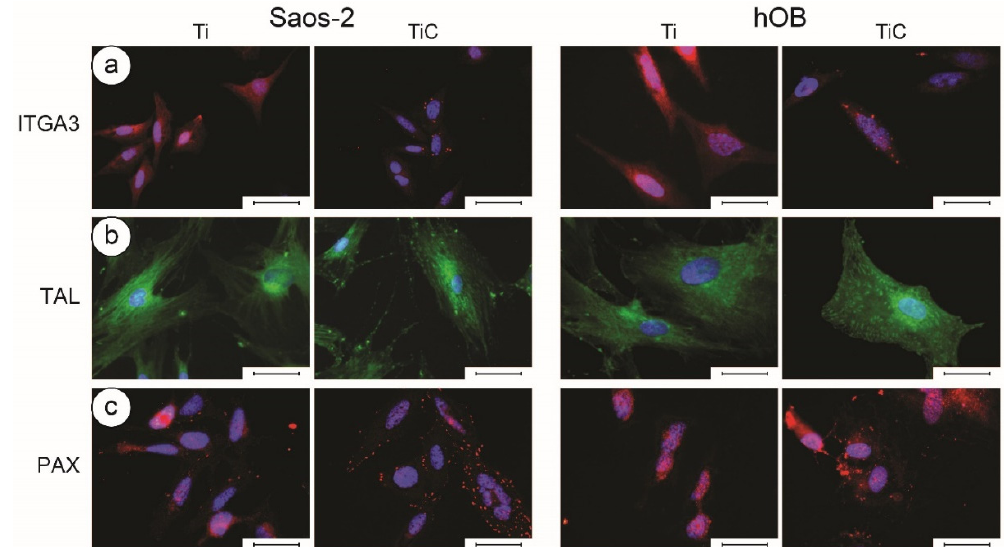
Figure 6. Immunofluorescence images of integrin α 3 β 1, talin and paxillin in Saos-2 cells and in human primary osteoblasts (hOB). Panel ( a ): The Saos-2 (left panels) and the hOB cells (right panels) were grown for 96 h on glass slides coated with 10.5 nm of titanium or the nanostructured TiC layer, treated with primary monoclonal antibodies against integrin α 3 β 1 (10 µg/mL). Panel ( b ): The cells were treated with primary monoclonal antibodies against talin (10 µg/mL). Panel ( c ): Cells were treated with primary monoclonal antibodies against paxillin (10 µg/mL). In all cases, the treatment was followed with Alexa Fluor 568 goat anti-mouse secondary antibodies, diluted 1:500, and the nuclei were stained with the organic dye DAPI. The images were collected with a magnification of 63× for ITGA and PAX, and of 100× for TAL, and the bar represents 100 µm. Obtained with permission from [64] . Copyright (2016), with permission from PLoS ONE.